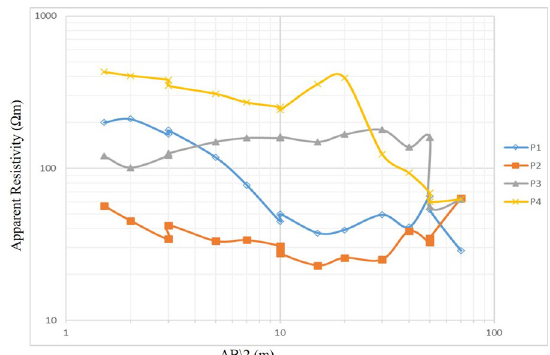
Fig. 10 Apparent resistivity curves of the four VES points (P1, P2, P3, and P4)